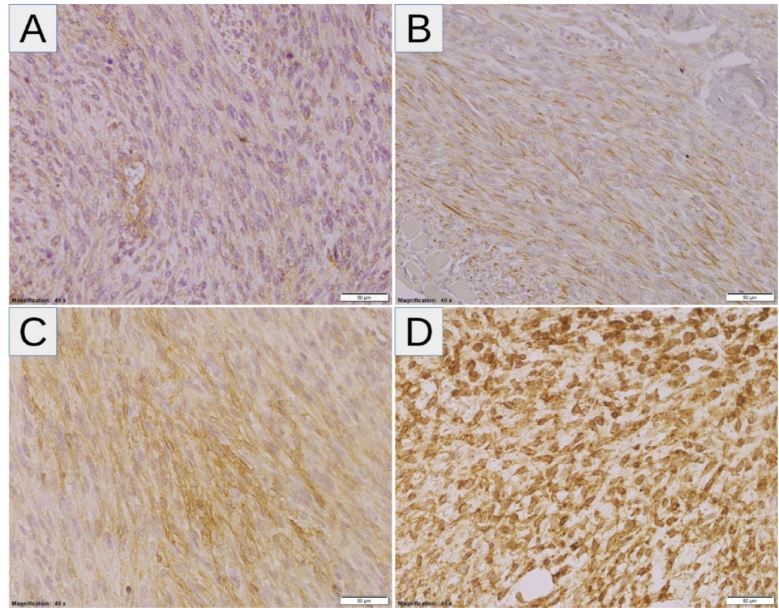
Figure 5. ( A – D ) Representative CA9 staining patterns in MPNST: ( A , B ) Cases with low- (1+) ( A ) and intermediate-intensity (2+) ( B ) predominantly membranous expression of CA9 (the expression coefficient—7, low-expression and 8, high-expression, respectively). ( C , D ) Cases with predominantly intermediate/high (2+/3+) ( C ) and high intensity (3+) ( D ) membranous and cytoplasmic expression of CA9 (the expression coefficient—11, high-expression, and 12, high-expression, respectively). Abbreviations: CA9—carbonic anhydrase 9, MPNST—malignant peripheral nerve sheath